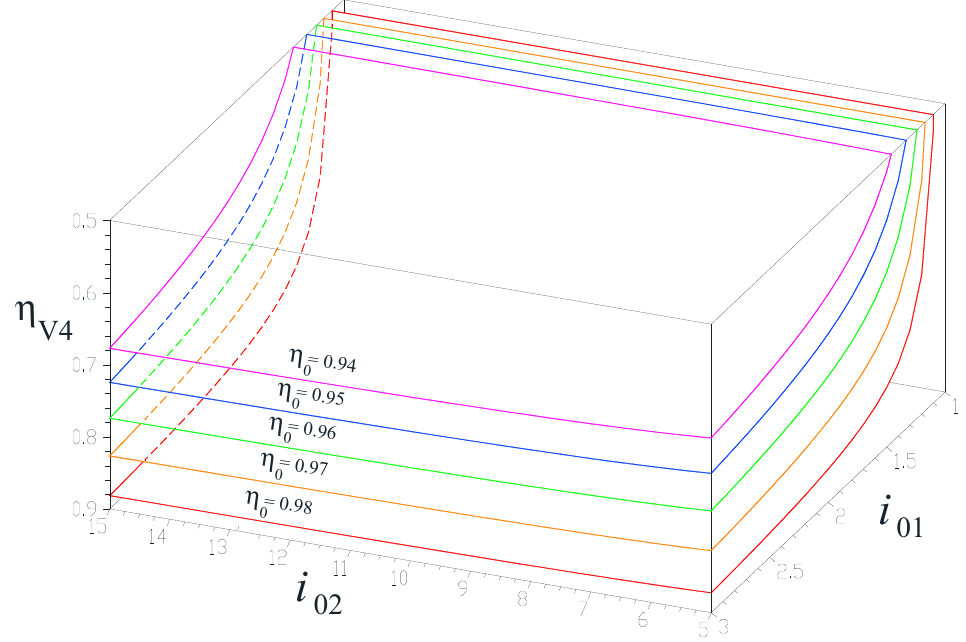
Figure 9. Efficiency of the 1-DOF speed increaser variant V4 (Figure 5d) as functions of the interior kinematic ratios i 01 and i 02 , for various gear-pair efficiencies η 0 = 0.94, 0.95, 0.96, 0.97 and 0.98.